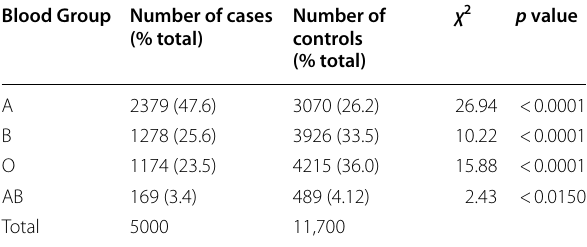
Table 1 Distribution of cases and controls as per their blood types